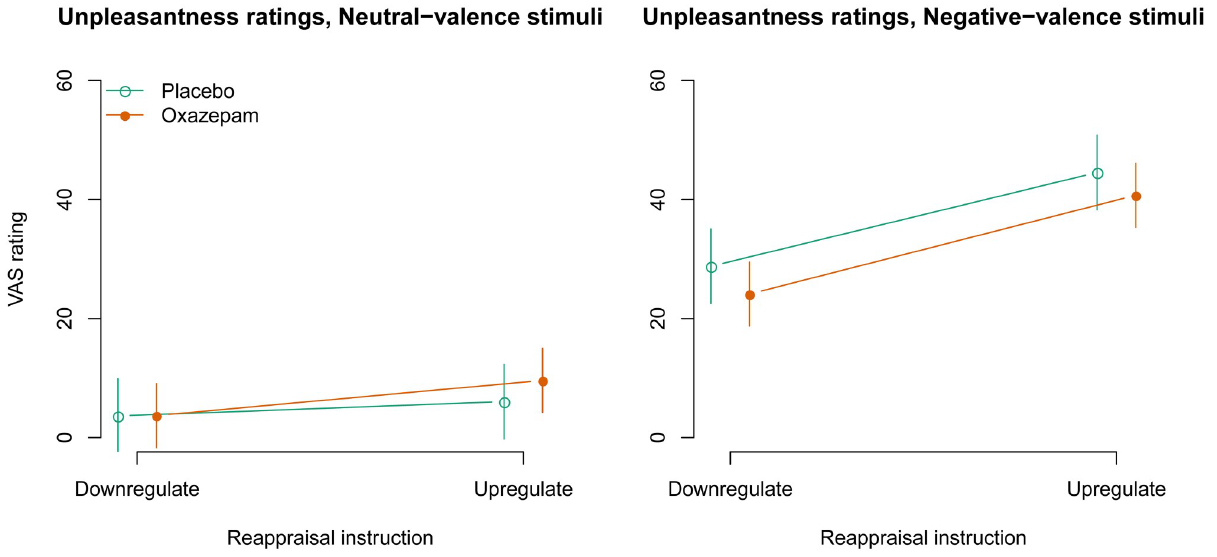
Fig 2. Rated unpleasantness: Model estimates with 95% confidence intervals.